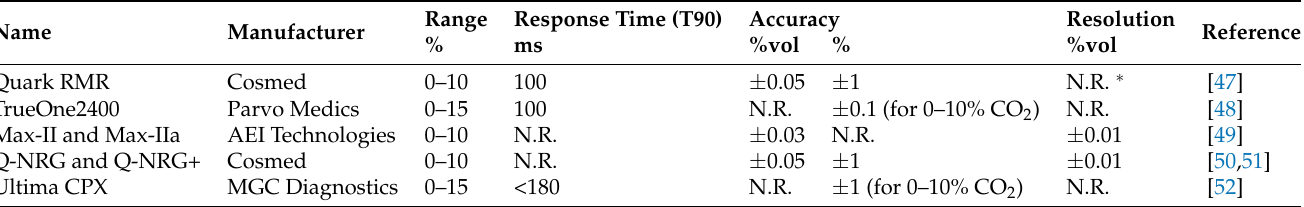
Table 2. Overview of the technical specifications (measurement range, T90 response time, accuracy and resolution) of NDIR carbon dioxide sensors of commercial indirect calorimeters, as reported by the